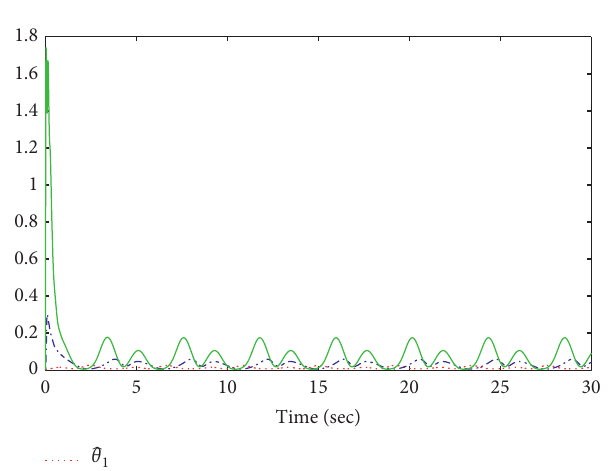
Figure 6: The state variable ξ